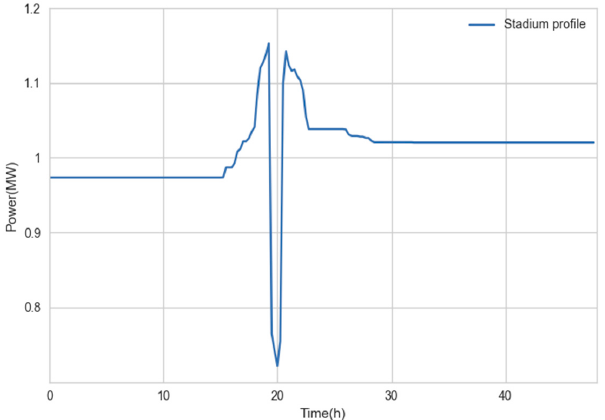
Figure 12. The total load profile of the ArenA stadium in Scenario 3 with 1000 EVs present. Now, the stadium is a net exporter of energy when the majority of the EVs are charging to compensate for their energy need and to support the network.